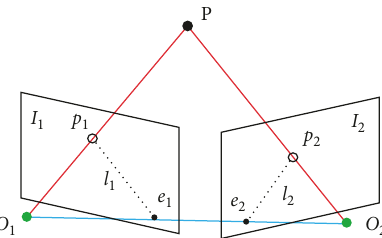
Figure 3: One point in two adjacent image frames (epipolar